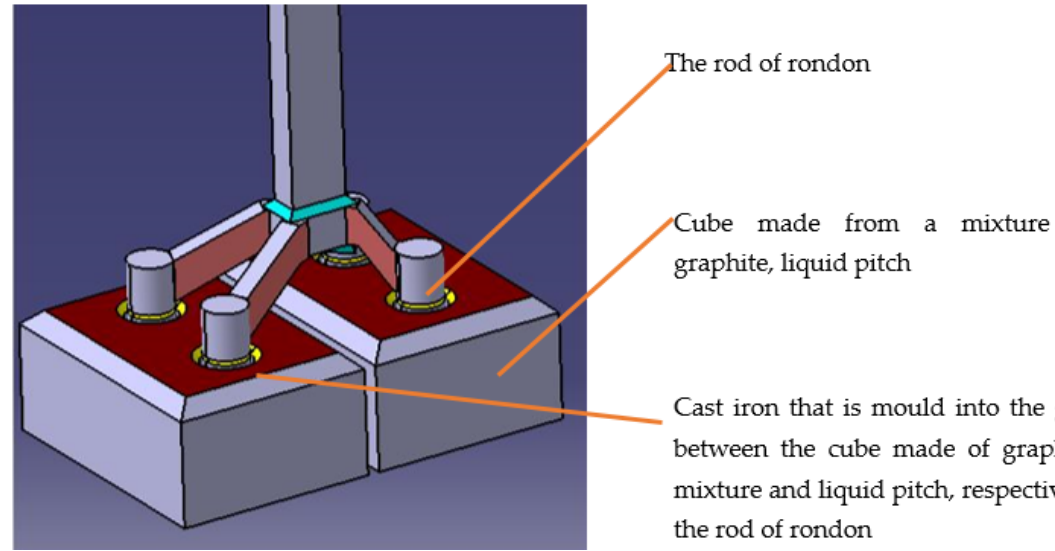
Figure 2. Anode assembly.